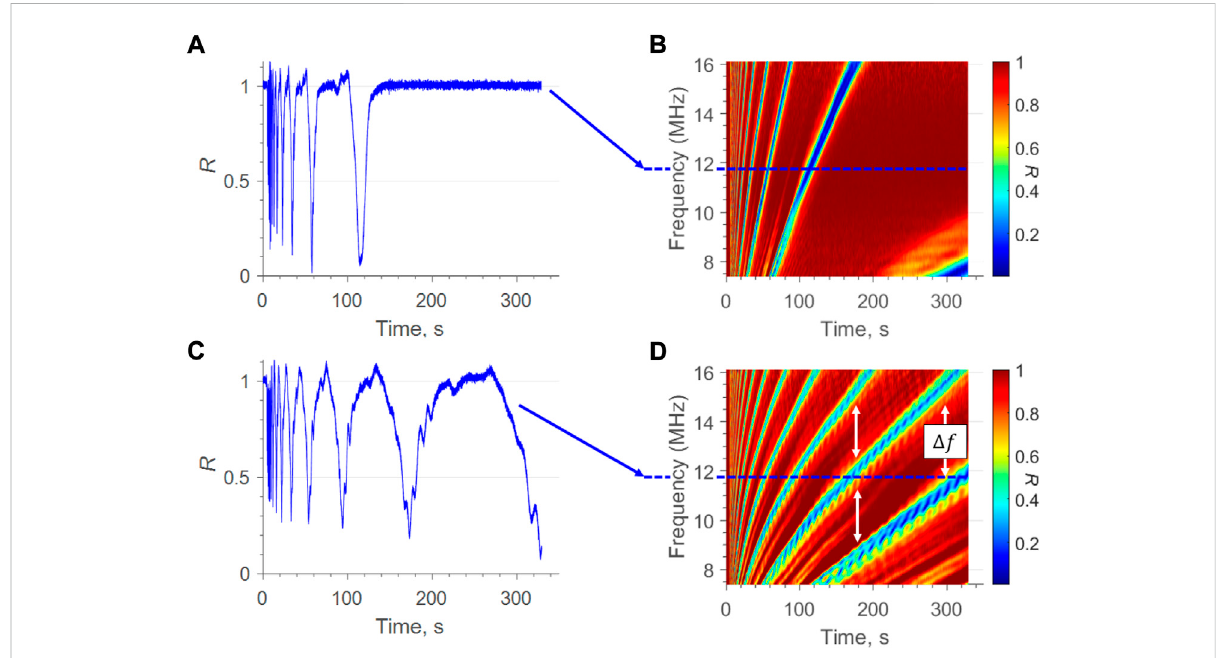
FIGURE 8 (A,C) single frequency analysis of s3 and n10 oils respectively. Plots (B,D) show the spectrogram oil map of the same oils.